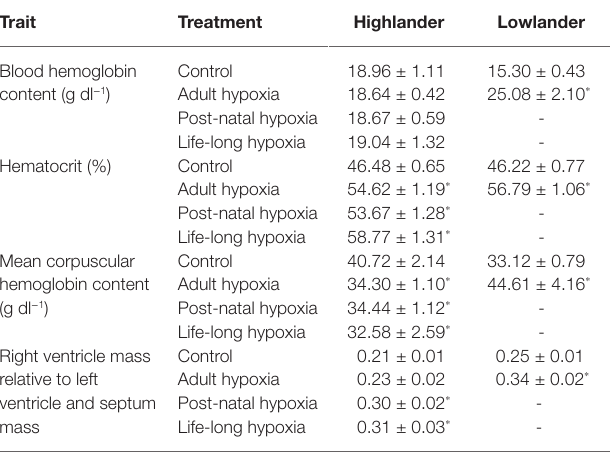
TABLE 3 | Tissue measurements in highland deer mice and lowland white- footed mice exposed to hypoxia.